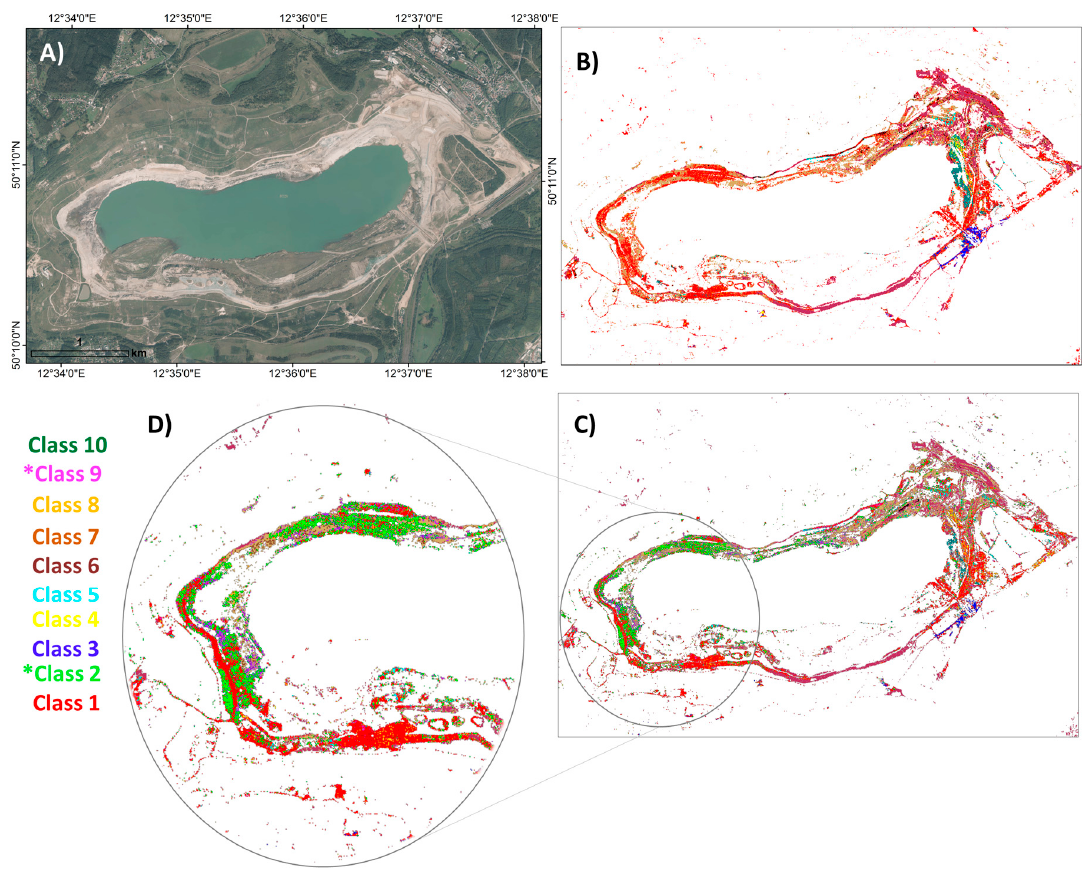
Figure 8. Medard Lake, mineral mapping: ( A ) orthophoto showing the Lítov dump, ( B ) classification using Scenario 1 (absorption feature parameters derived only from the HyMap data were used for the consequent mineral mapping), ( C ) classification using Scenario 2 (absorption feature parameters derived from both datasets, HyMap and AHS, were used for the consequent mineral mapping), ( D ) enlargement of the area of interest. The mapped classes correspond to the mineral classes in the Table 1, *Class 2 and *Class 9: two additional classes mapped when using Scenario 2.